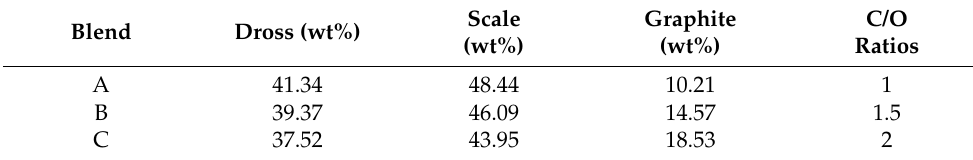
Table 3. Composition in the blend